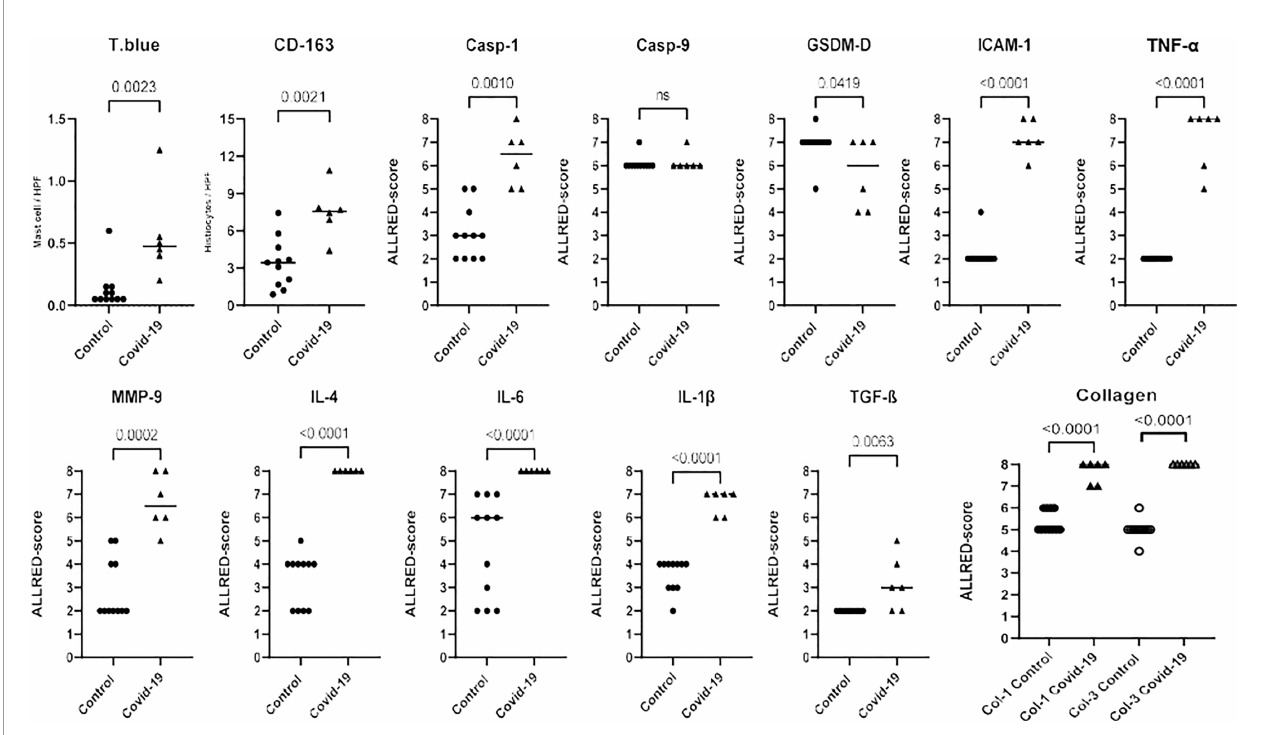
FIGURE 2 | Graphical representation of the immunohistochemical analysis according to the biomarker expression (Toluidine Blue; CD-163; Casp-1; Casp-9; GSDM- D; ICAM-1; TNF- a ; MMP-9; IL-4; IL-6; IL-1 b ; TGF- b ; Collagen 1 and 3) in COVID 19 cases and controls. Biomarkers were analyzed using Allred scoring system: score 0-5 depending on the proportion of cells which are stained (proportion score [PS]: score 0 = none stained cells, score 1 = 1%, score 2 = 1-10%, score 3 = 11-33%, score 4 = 34-66% and score 5 = 66-100%) and score 0-3 depending on the intensity of staining (intensity score [IS]: score 0 = none stained cells, score 1 = weak, score 2 = moderate, score 3 = strong). The semiquantitative analysis was obtained by summing the two scores (proportion and intensity of positivity), ranging from 0 to